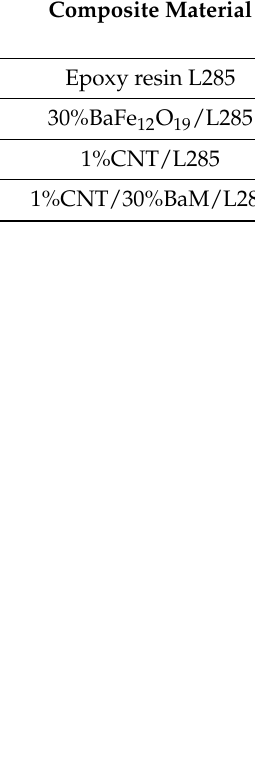
SE T , dB ε (cid:48) r ε ” r µ (cid:48) r Ref. f = 40 GHz, d = 2.6